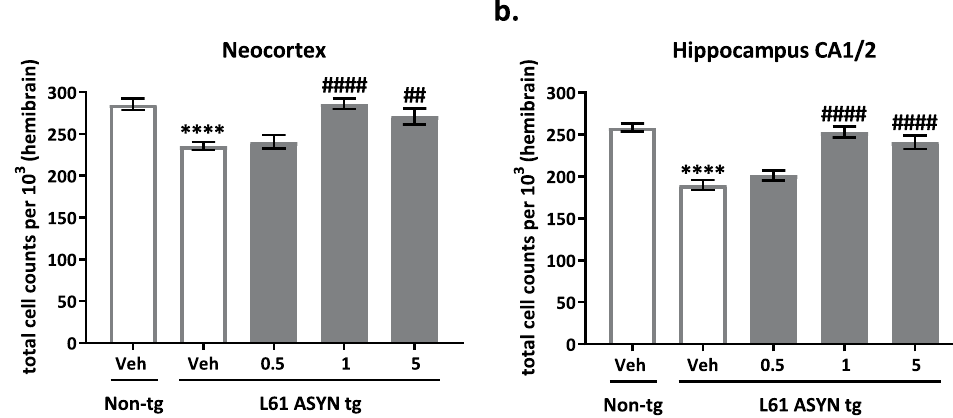
Figure 9. NPT200-11 administration normalizes NeuN immunopositive cell counts in cortex and hippocampus of Line 61 ASYN transgenic mice. There was a statistically significant decrease in NeuN immunopositive cell counts in the (a) neocortex ( **** p < 0.0001 vs. vehicle-treated non-transgenic controls ) and (b) hippocampus ( **** p < 0.0001 vs. vehicle-treated non-transgenic controls ). NPT200-11 administration (1 & 5 mg/kg) produced statistically significant normalizations in NeuN immunopositive cell in both regions ( ## p < 0.01 and #### p < 0.0001 vs. vehicle-treated Line 61 ASYN transgenic controls